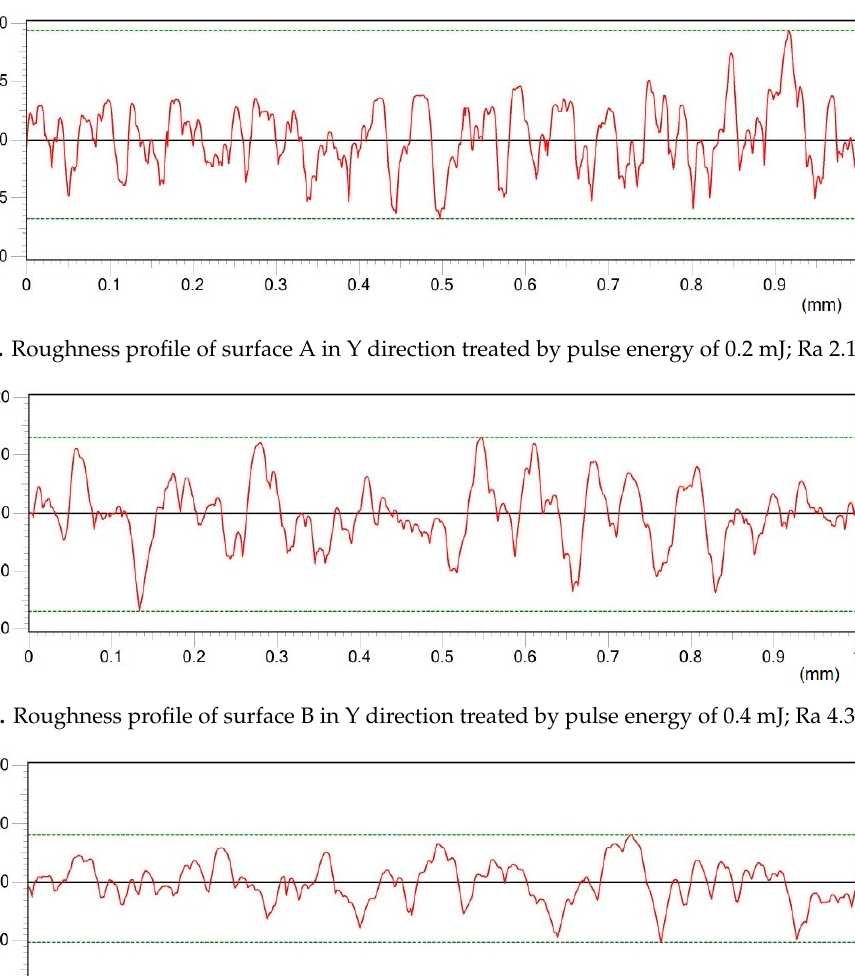
Figure 5. Comparisons of the machined surface profiles with indicated moved molten material.